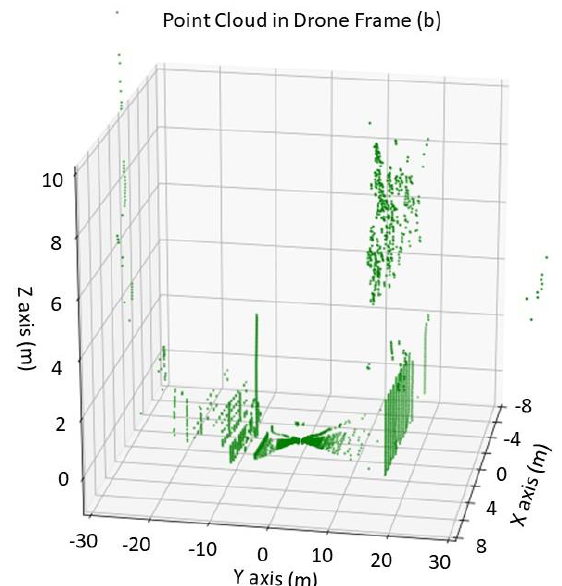
Figure 10. Non- calibrated point cloud RP in the UAV reference system (x’, y’, z’). Figure 10. Non-calibrated point cloud RP in the UAV reference system (x (cid:48) , y (cid:48) , z (cid:48) ). With the data in the same reference system, i.e., when the rotation matrix has